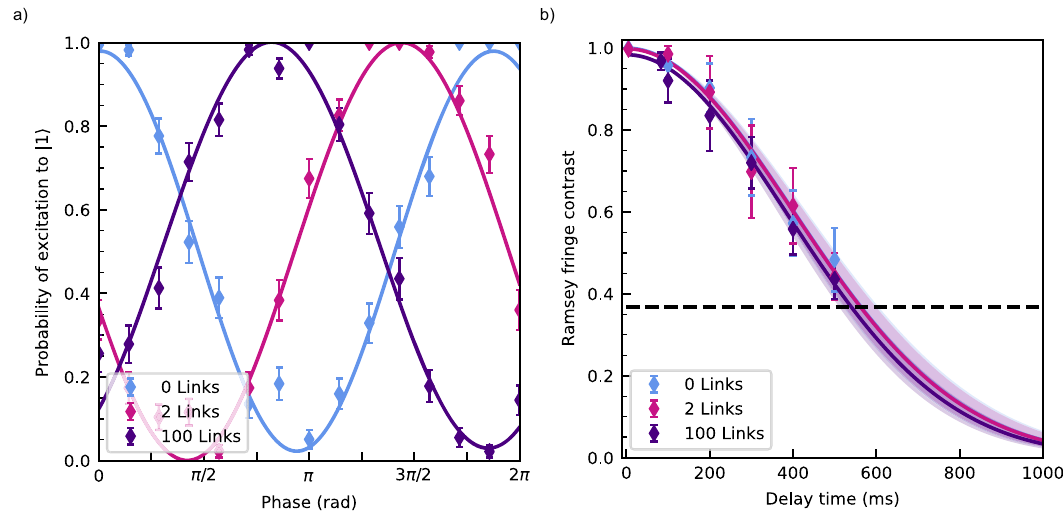
Fig. 4 | Ramsey interferometry. a Ramsey fringes measured after 0, 2 and 100 links. The solid lines represent a sinusoidal fi t to the data. For each dataset τ =100 ms,100averagesweretakenperdatapoint.Errorbarsarestandarddeviations.The Ramsey fringe contrasts are found to be 0.96(2), 1.00(2) and 0.97(2) for 0, 2 and 100 links respectively. b The Ramsey fringe contrast as a function of time for 0, 2